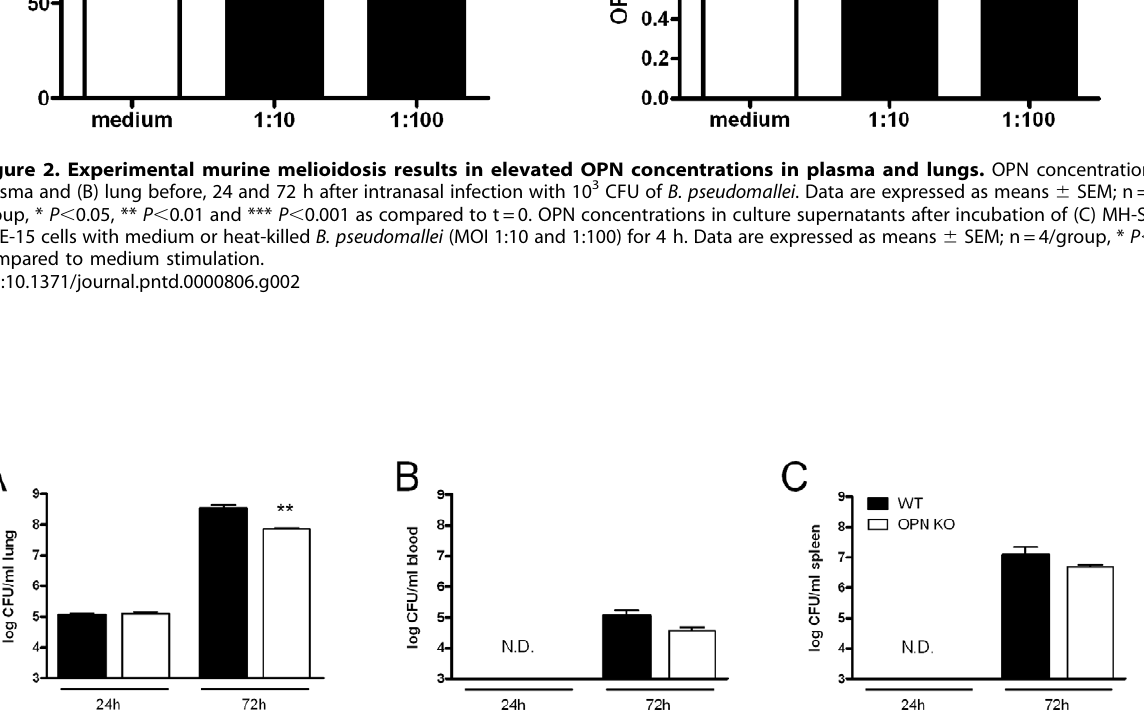
Figure 3. Decreased pulmonary bacterial growth in OPN KO mice. WT (black bars) and OPN KO (white bars) mice were infected intranasally with 10 3 CFU of B. pseudomallei and bacterial loads were determined 24 and 72 h after infection in (A) lung, (B) blood, and (C) spleen. Data are expressed as means 6 SEM; n=8 mice/group, ** P , 0.01 as compared to WT mice. N.D. means not detectable.